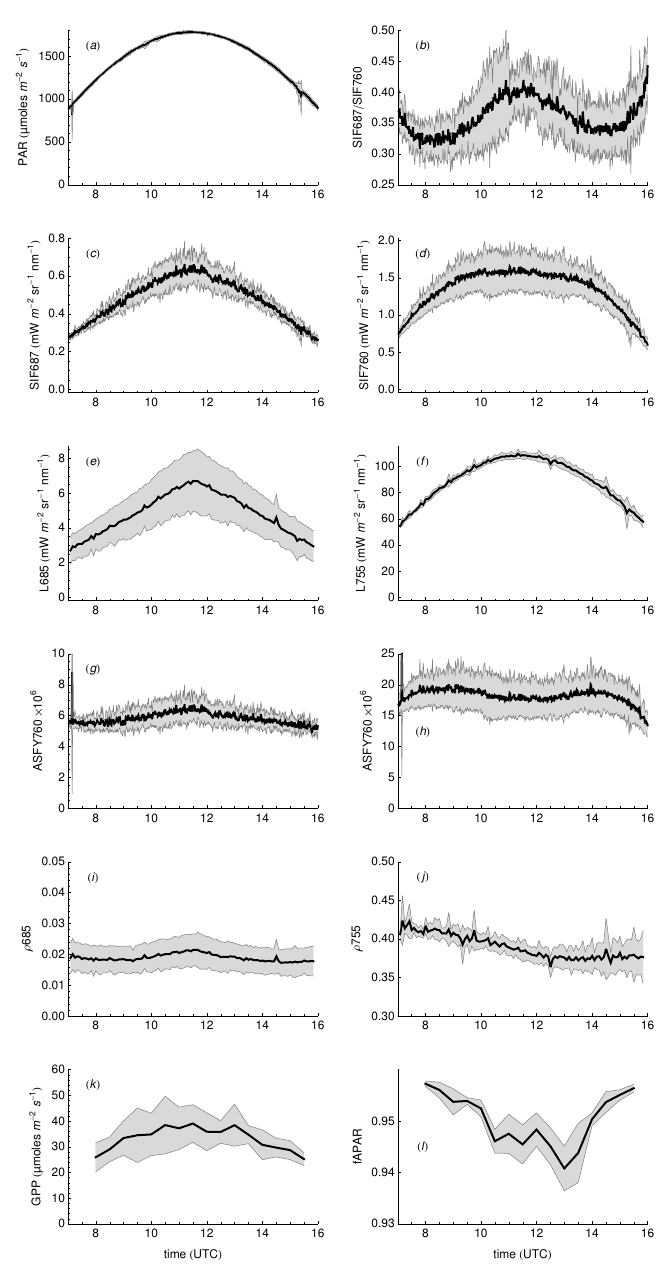
Figure 3. Diurnal cycles of optical signals and gross primary production (GPP). Mean of six clear sky days during the steady mature state of the crop (dark solid line) ± one standard deviation (gray area). ( a ) PAR; ( b ) Fluorescence ratio SIF687/SIF760; ( c , d ) Fluorescence radiances at 687 nm and 760 nm (SIF687, SIF760); ( e , f ) Vegetation radiances at 685 and 758 nm ( L 685, L 758); ( g , h ) Apparent Spectral Fluorescence Yield (ASFY) at 687 and 760 nm (ASFY687, ASFY760); ( i , j ), top of canopy (TOC) reflectance at 685 nm and 755 nm; ( k ) GPP; ( l ) fraction of absorbed PAR (fAPAR). Days included in the analysis are: 05/17, 05/19, 05/21, 05/22, 05/24, 06/04 (day of year (DOY)s 137, 139, 141, 142, 144, 155,